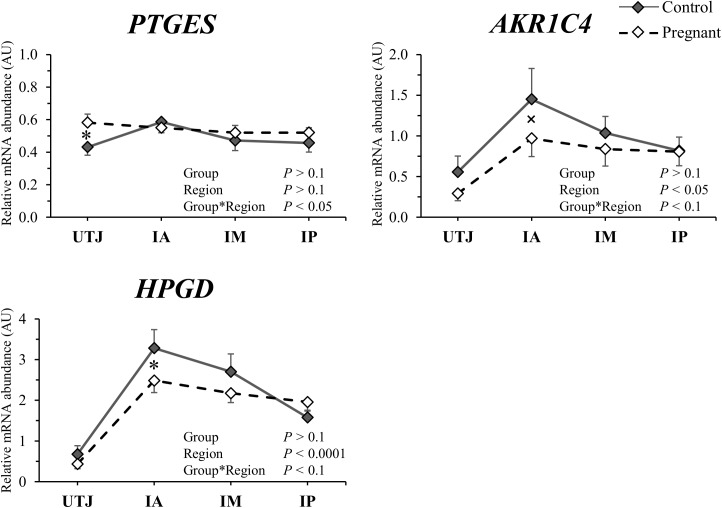
Relative mRNA abundance of eicosanoid biosynthesis related genes (arbitrary units; AU; mean ± SEM) for control (solid lines) and pregnant (dashed lines) cows in the uterotubal junction (UTJ), anterior (IA), medial (IM) and posterior (IP) regions of the uterine horn ipsilateral to the CL.*P < 0.05 and ˟P < 0.1 denotes that significant differences were reached or approached, respectively, between groups at each specific region.